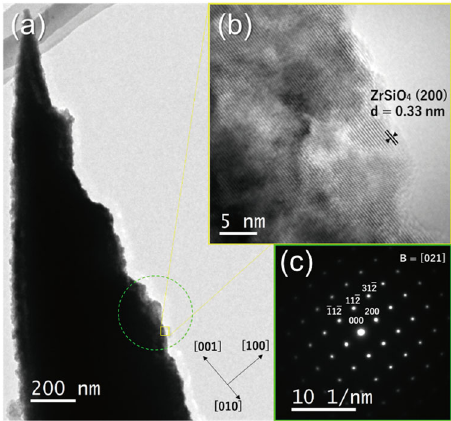
Fig. 12 TEM images and SAED pattern of the rod crystal. a Bright- fi eld TEM image of the rod crystal, b HRTEM image, and c SAED pattern. The scale bar on the left image is 200 nm, the upper right is 5 nm and the bottom right, 10 nm − 1